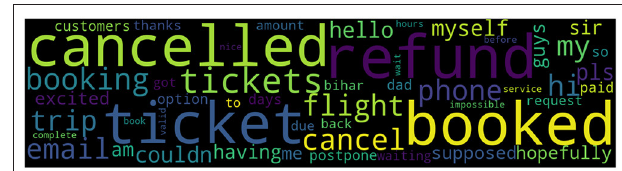
FIGURE 4 | Example of a word cloud based on the term